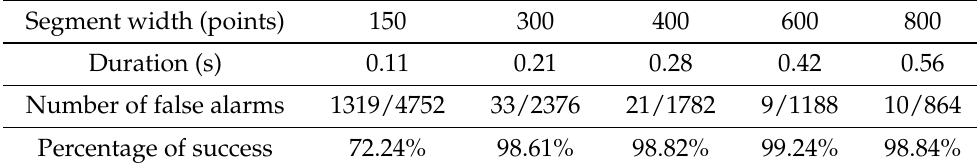
Table 13. Results of PCA model using different segment